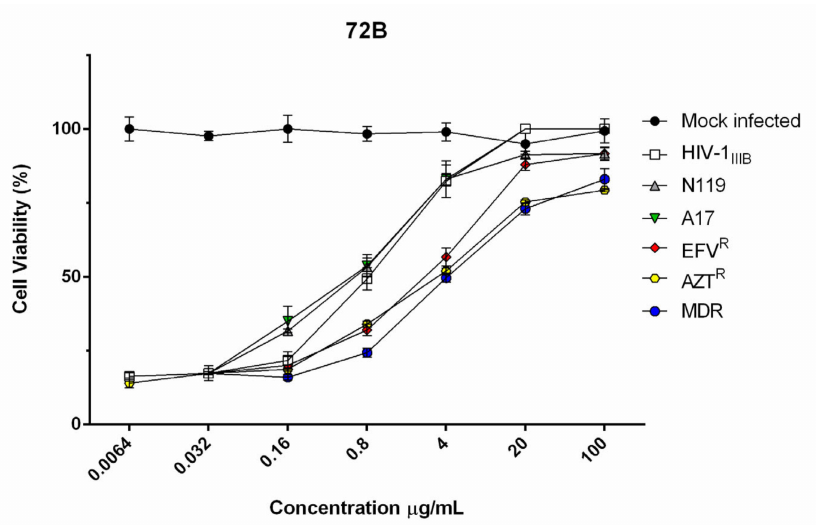
Figure 1. Cytotoxicity and anti HIV-1 activity of the 72B extract. To evaluate 72B antiviral activity in HIV-1 wt and drug resistant strains, several concentrations of extract (100 up to 0.0064 µ g / mL) were used to inhibit wt IIIB and clinically relevant RT-inhibitor resistant strains (N119, A17, EFV R , AZT R , MDR). The viability of HIV-1 infected MT-4 cells was estimated by MTT assay, 4 days post-infection. The number of live cells was expressed as a percent of mock infected, non-treated, control cells. Data are expressed as means ± SD of at least three independent